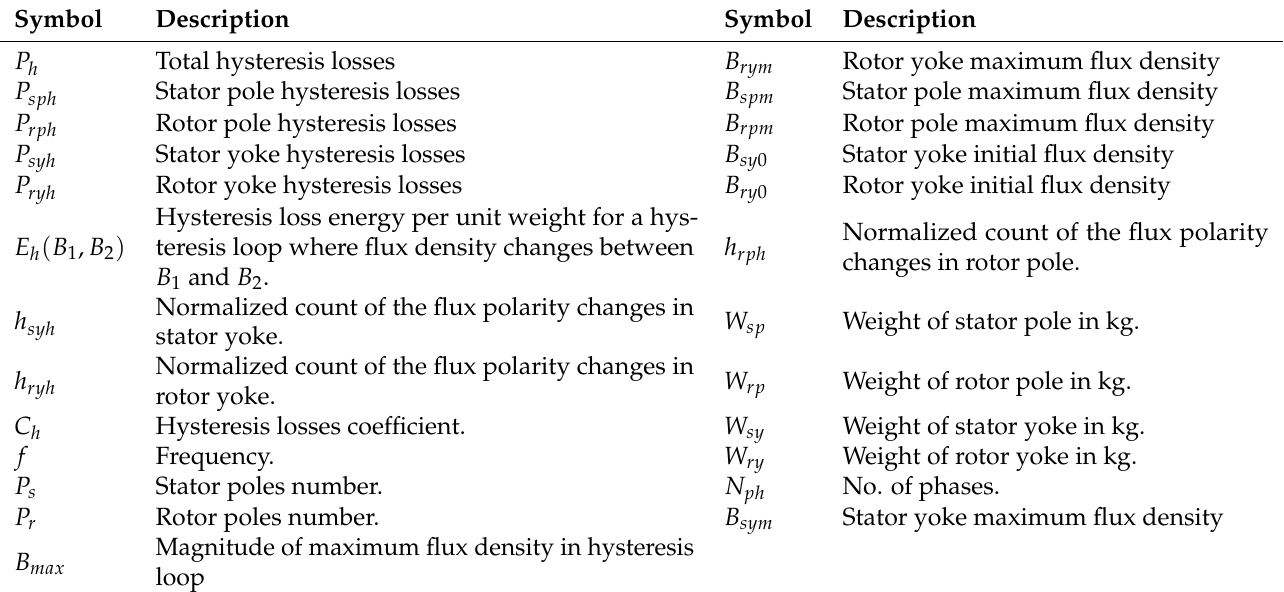
Table 3. Symbols in Equations